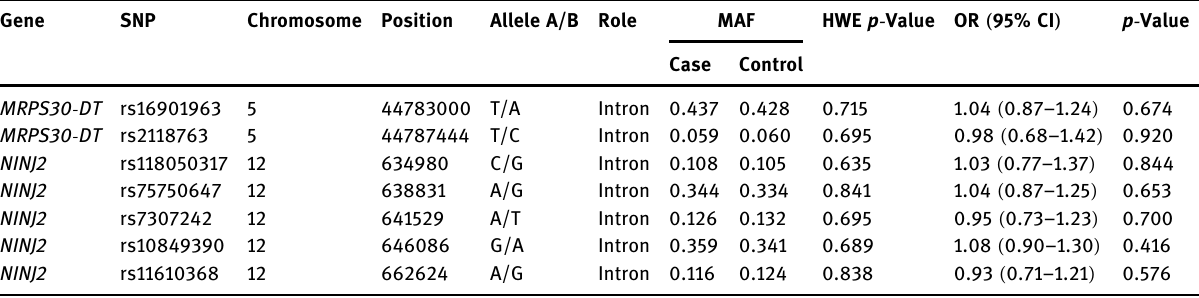
Table 2: Information about selected SNPs in MRPS30 - DT and NINJ2